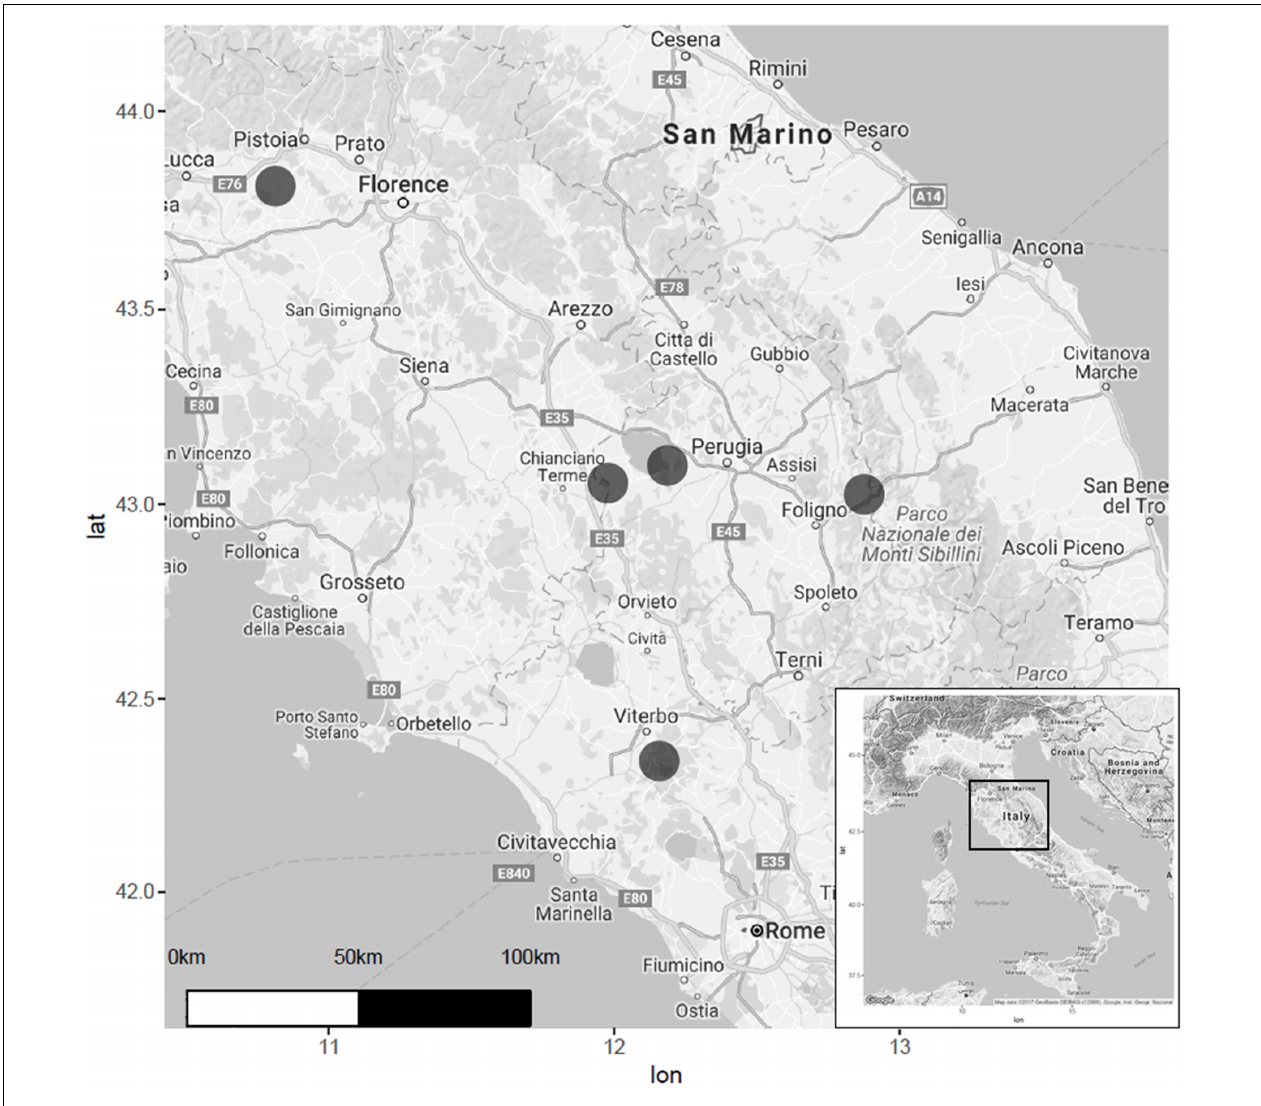
FIGURE 1 | Map showing the distribution of Italian lakes selected for